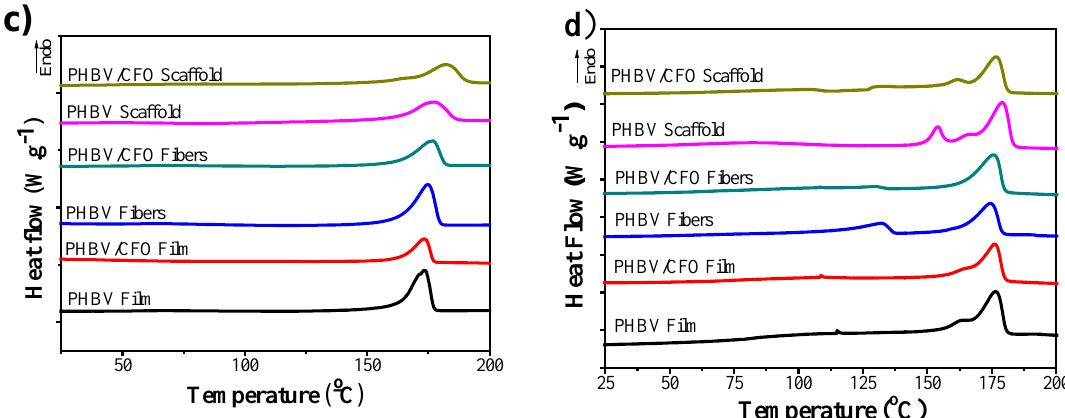
Figure 4. FTIR spectra of the different PHBV and PHBV/CFO morphologies before ( a ) and after ( b ) 6 weeks of immersion in SBF. DSC thermograms of pristine and PHBV/CFO composites ( c ) before and ( d ) after 6 weeks of immersion in SBF, respectively.